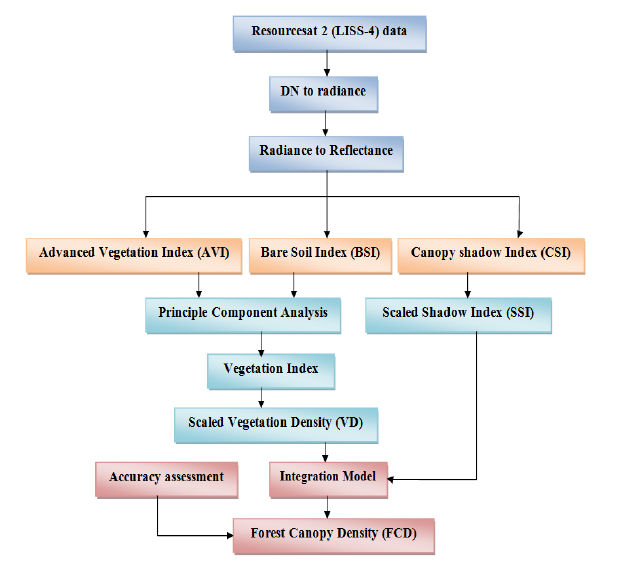
Figure 2. Flow chart of